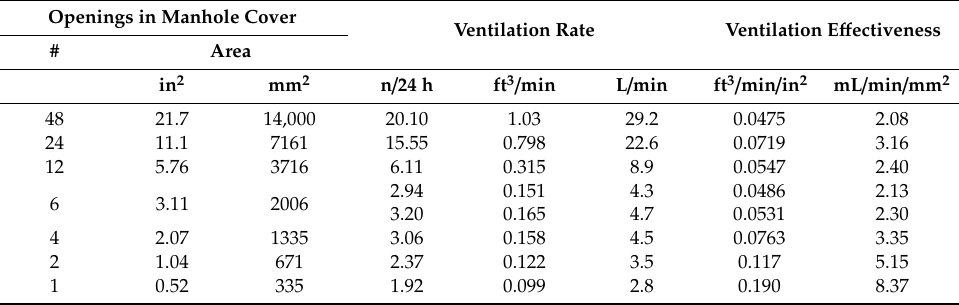
Table 2. Ventilation e ff ectiveness calculated from Jones et al. [2].